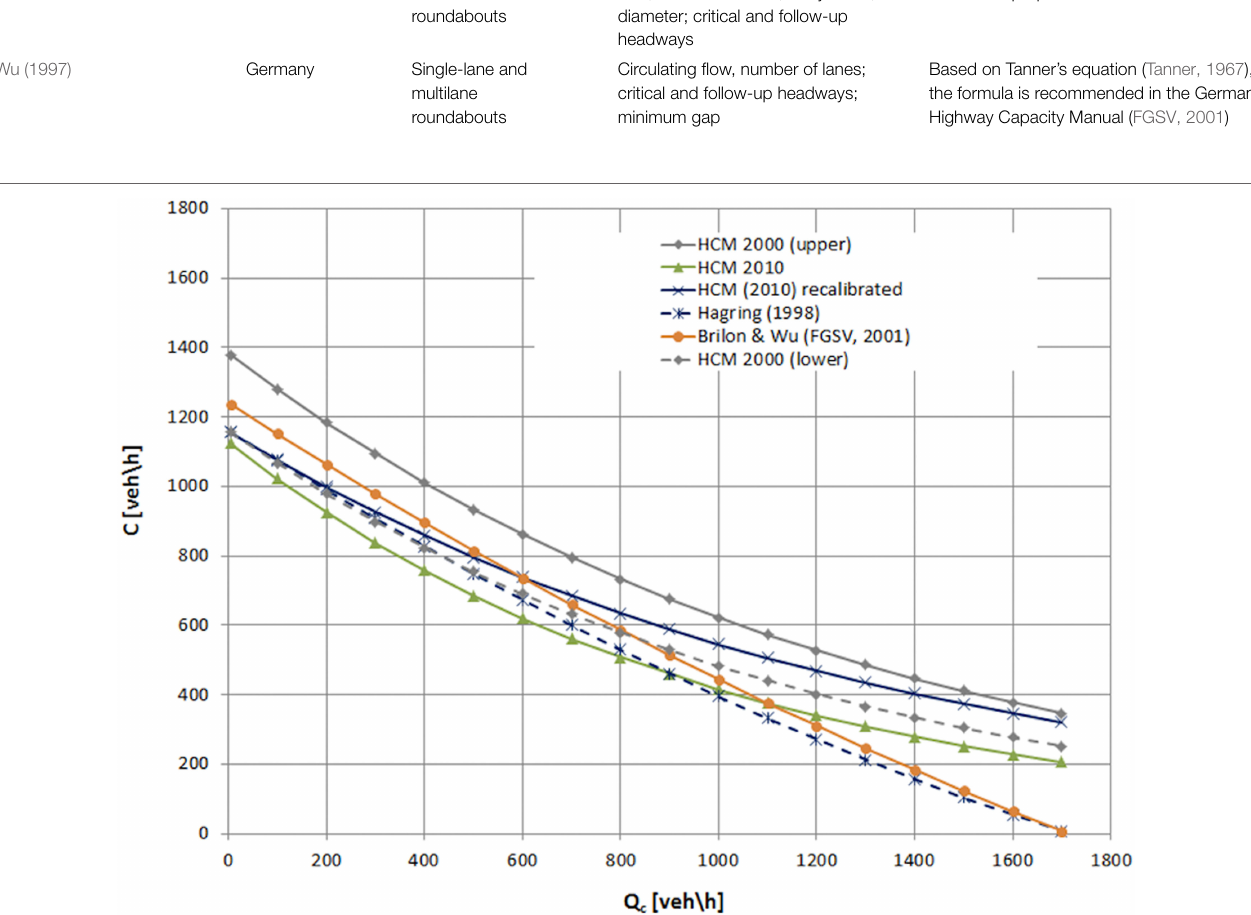
FIGURE 1 | Comparison of capacity models for single-lane roundabouts [note that C stands for capacity and Q c for circulating flow; the Brilon and Wu formula is recommended in the German Highway Capacity Manual (FGSV, 2001)] .